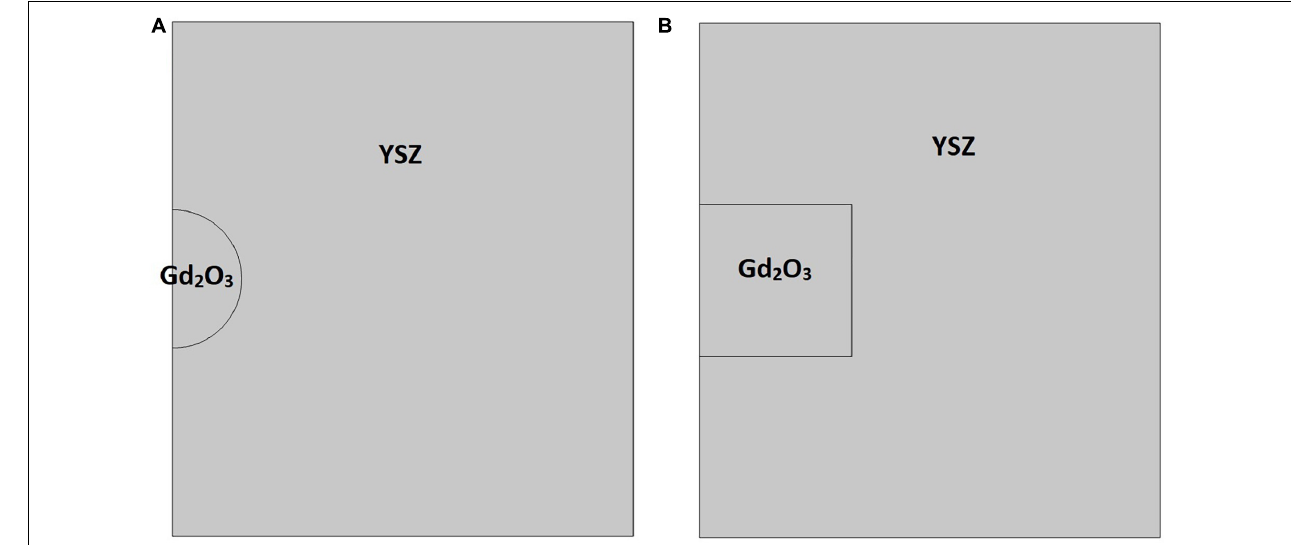
FIGURE 3 | Geometrical models of YSZ oxide pellet containing (A) lumped Gd 2 O 3 spherical particle and (B) mini-pellet.